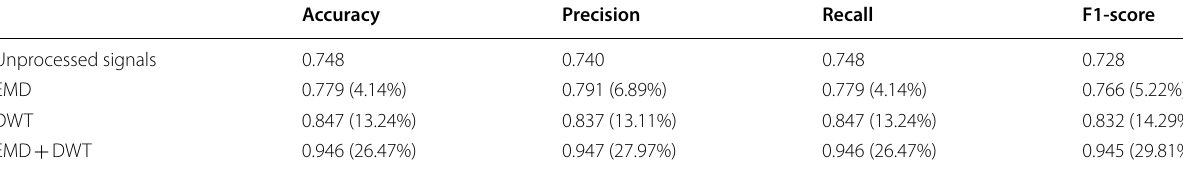
Table 4 Comparison of classification results between unprocessed signals and processed signals